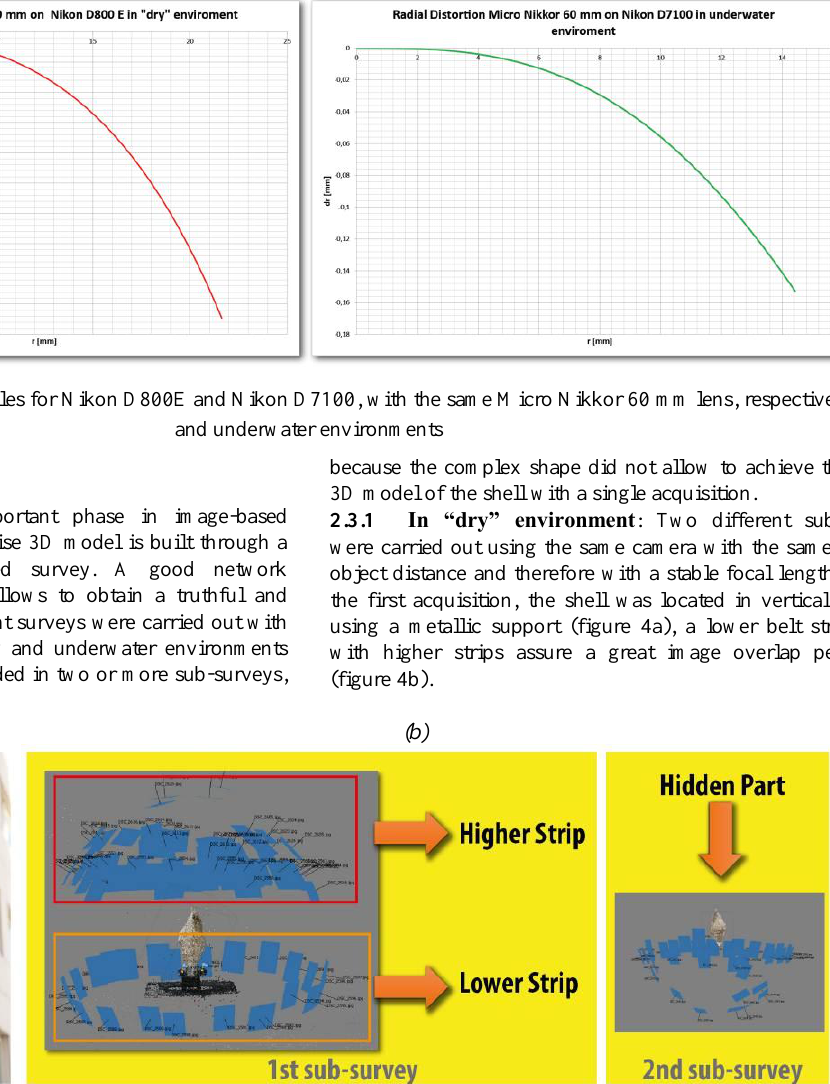
Figure 4. (a) Shell, metallic support and scale bar for the first sub-survey; (b) Network configuration of camera stations for “dry”